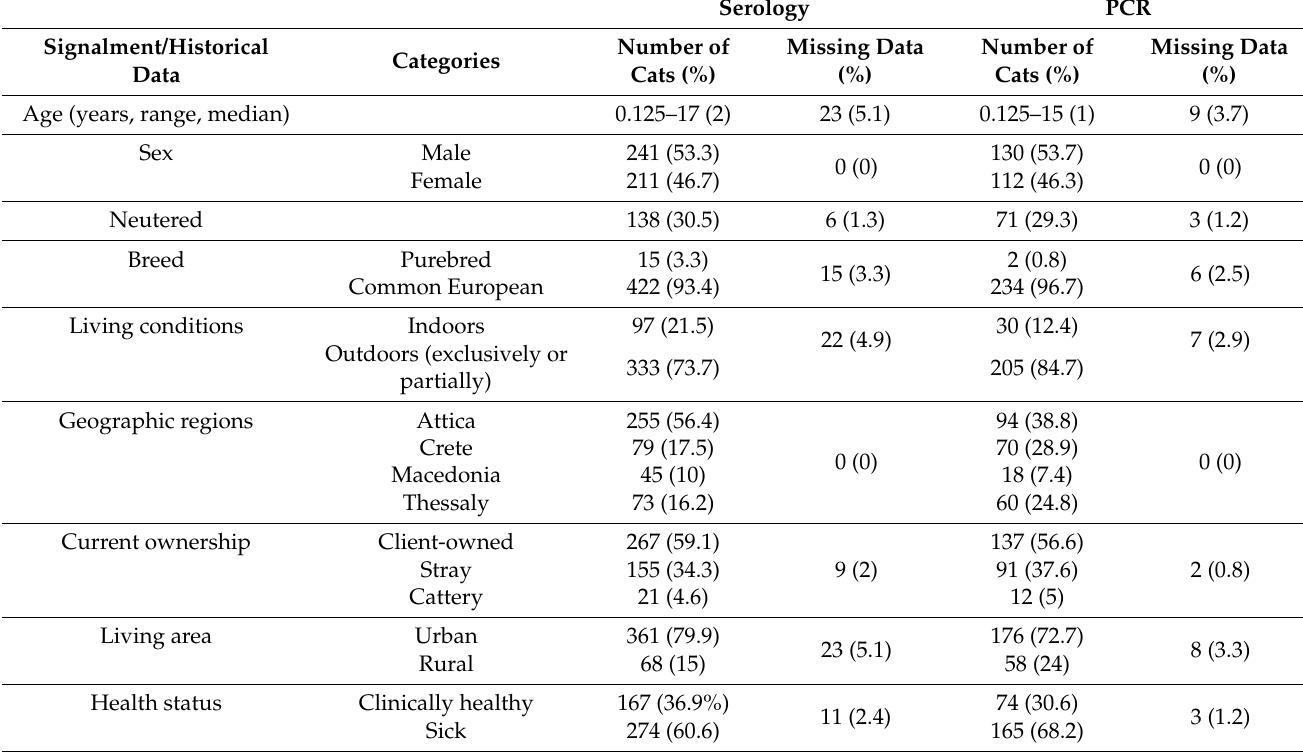
Table 1. Signalment and historical data of 452 cats selected for serology detection of B. henselae infection and of 242 cats selected for molecular detection of Bartonella spp. and haemoplasma species